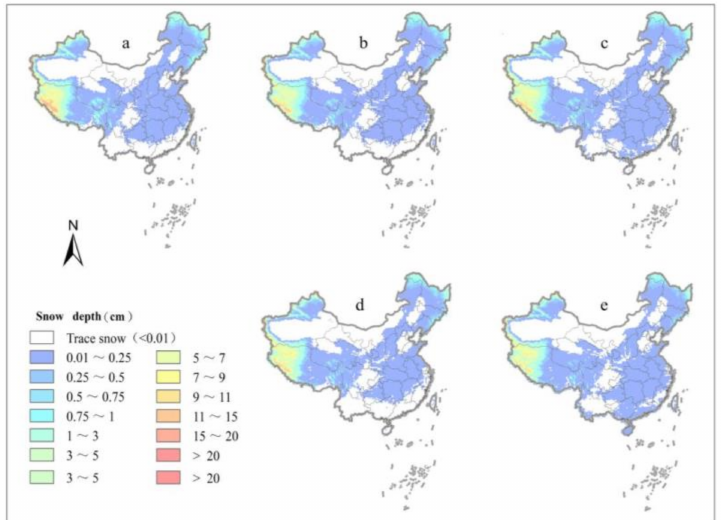
Figure 11. Average annual snow depth distribution in China based on NEX-GDDP data,